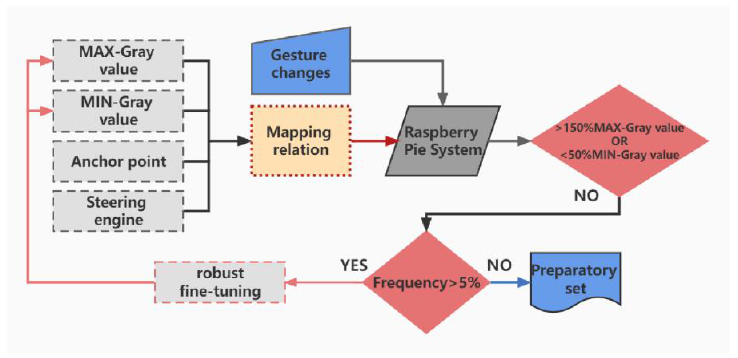
Figure 6. Flow chart of the robustness fine-tuning module.